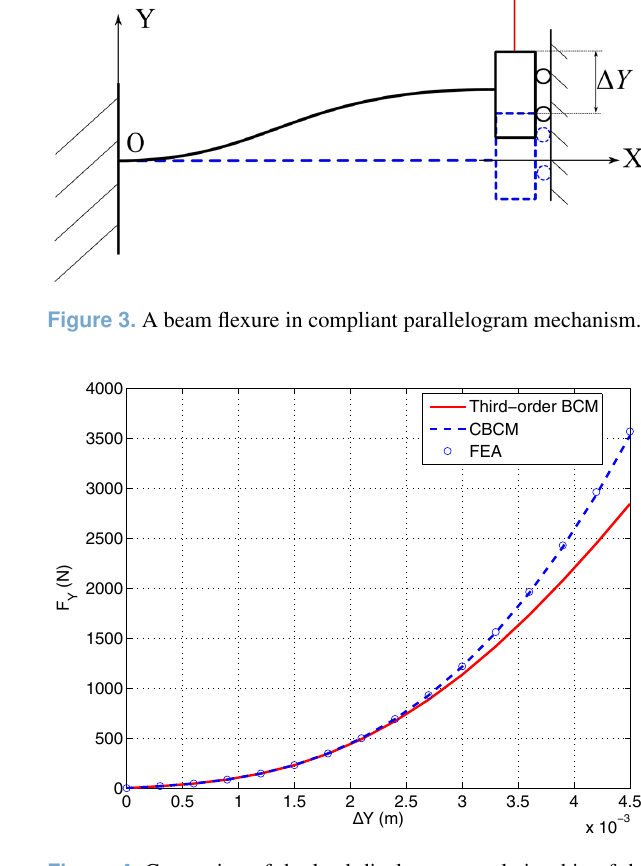
Figure 4. Comparion of the load-displacement relationship of the compliant parallelogram